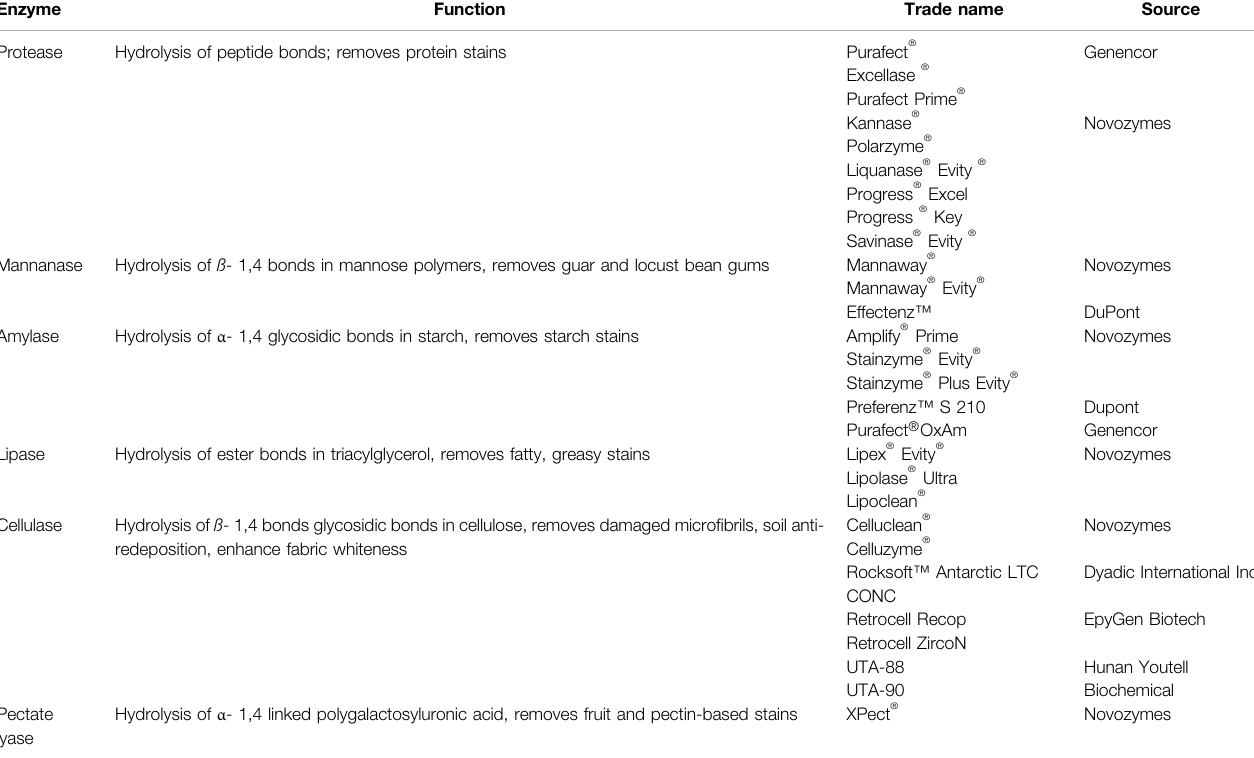
TABLE 1 | Commercially available psychrophilic enzymes used in detergents.